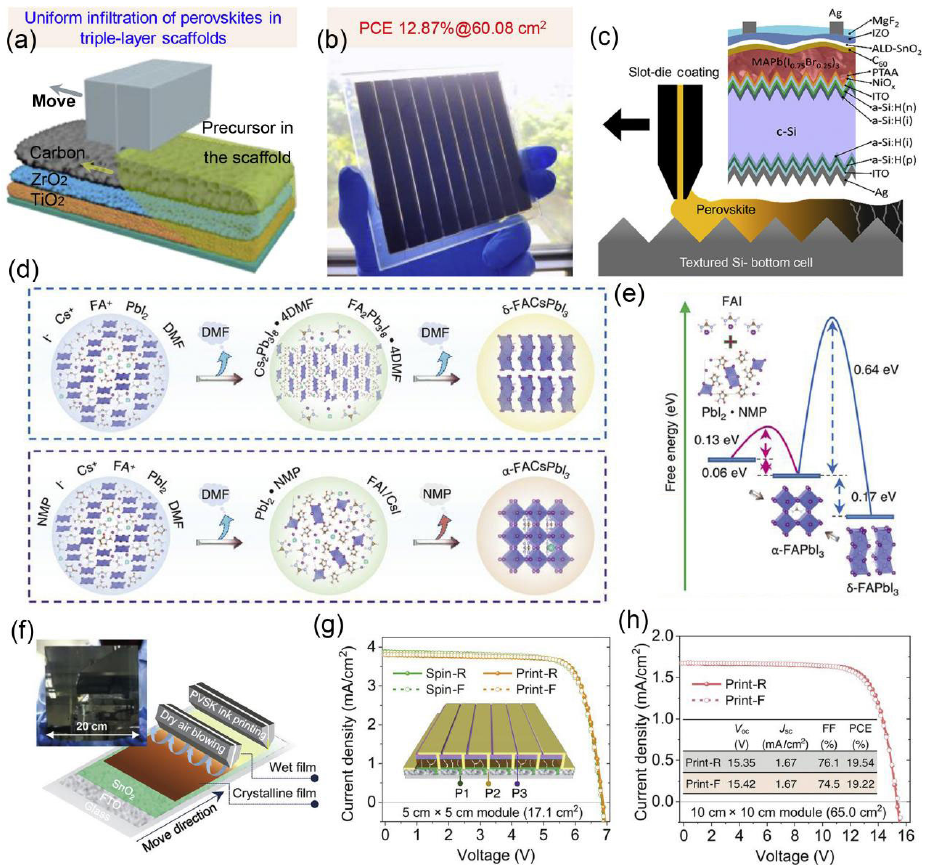
Figure 4 (a) Schematic illustration for slot-die coating perovskite precursors on TiO 2 /ZrO 2 /carbon mesoporous scaffold. (b) Photograph image of the fabricated PPMs of 60.08 cm 2 area with efficiency of 12.87%. Reproduced with permission from Ref. [44], © Elsevier B.V. 2020. (c) Device architecture schematic of perovskite/silicon tandem devices with slot-die-coated perovskite films. Reproduced with permission from Ref. [45], © American Chemical Society 2020. (d) Schematic diagram of formamidinium lead triiodide (FAPbI 3 ) perovskite crystal growth with or without NMP. (e) Free-energy calculation for the formation of corresponding FAPbI 3 perovskites. (f) Schematic illustration for the slot-die printing of perovskite films with low-pressure dry air blowing. (g) Champion J – V curves of the 5 cm × 5 cm series-connected PPMs based on the spin-coating and slot-die printing methods (F: forward scan; R: reverse scan). (h) Champion J – V curves of the 10 cm×10 cm PPMs with the slot-die printed perovskite films. Reproduced with permission from Ref. [46], © Bu, T. L. et al.